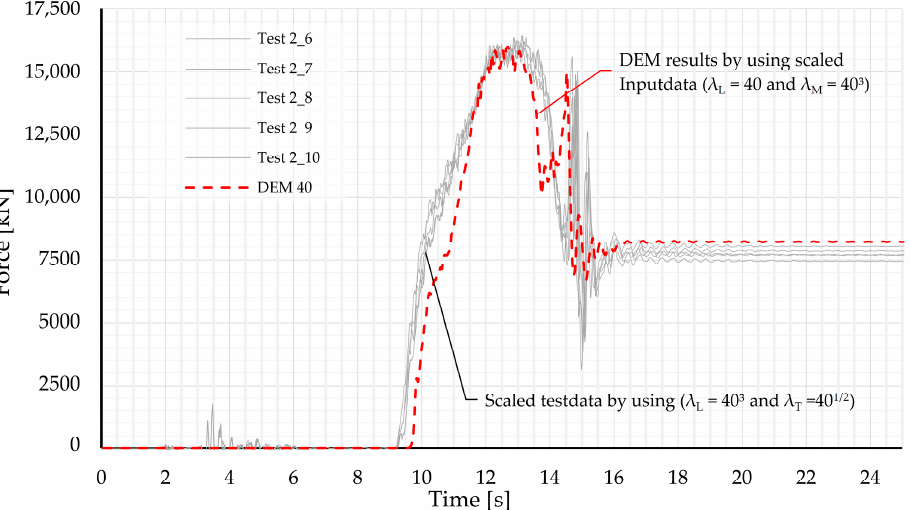
position of the “Box” for the analysis of particle velocities ( v ) and flow height ( h f ).